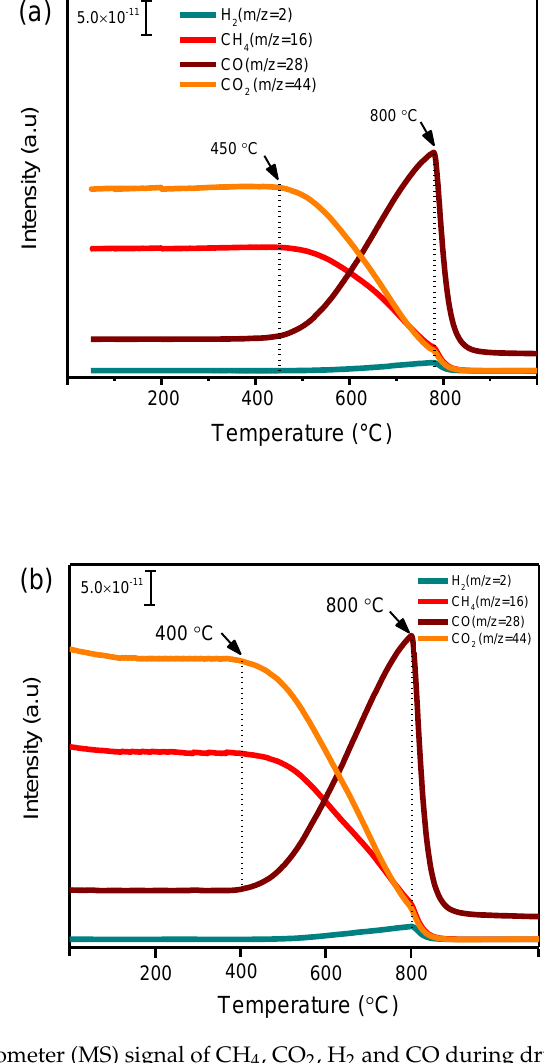
Figure 6. Mass spectrometer (MS) signal of CH 4 , CO 2 , H 2 and CO during dry reforming of methane over ( a ) nickel single-atoms catalyst (0.5Ni 1 /HAP-SAC) and ( b ) nanoparticles catalyst (5Ni/HAP-NP).